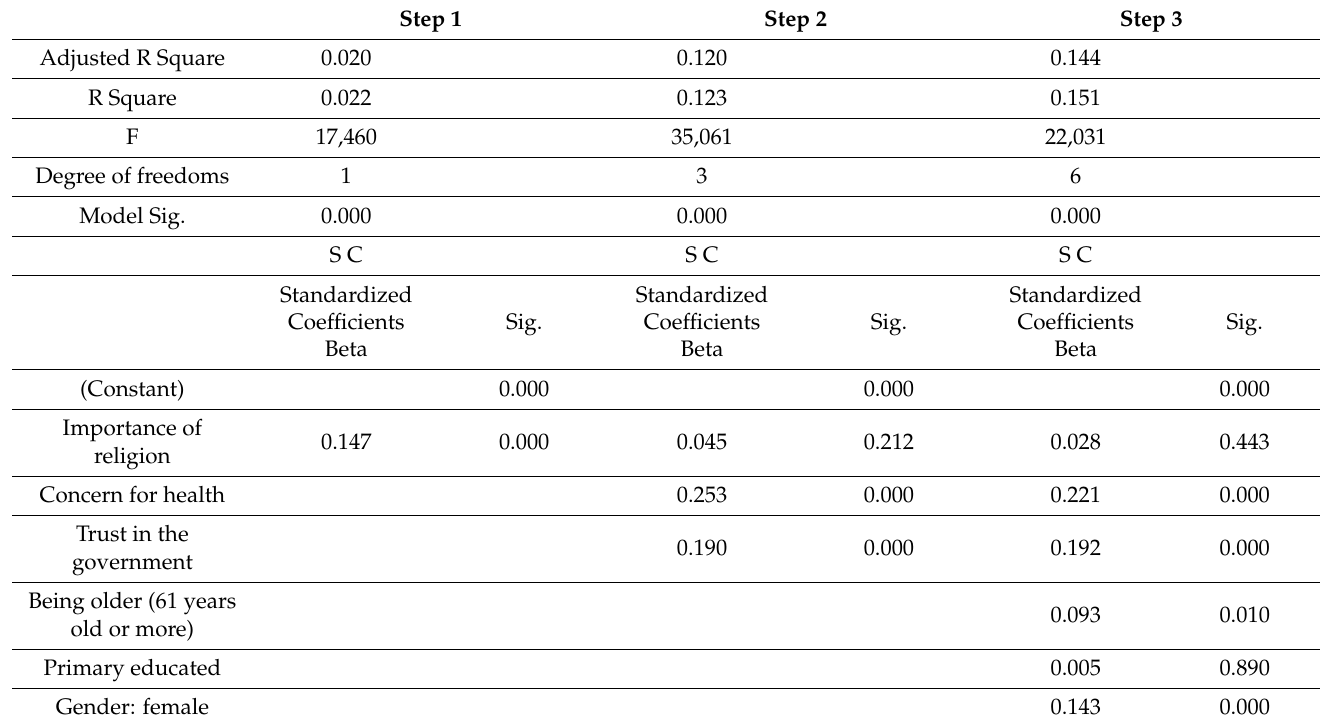
Table 4. Regression model: cooperation with selected